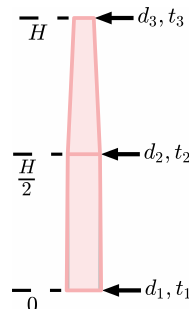
able, the turbine spacing constraint was slightly reformulated such that the distance between any two turbines in the wind farm was greater than the sum of the two rotor